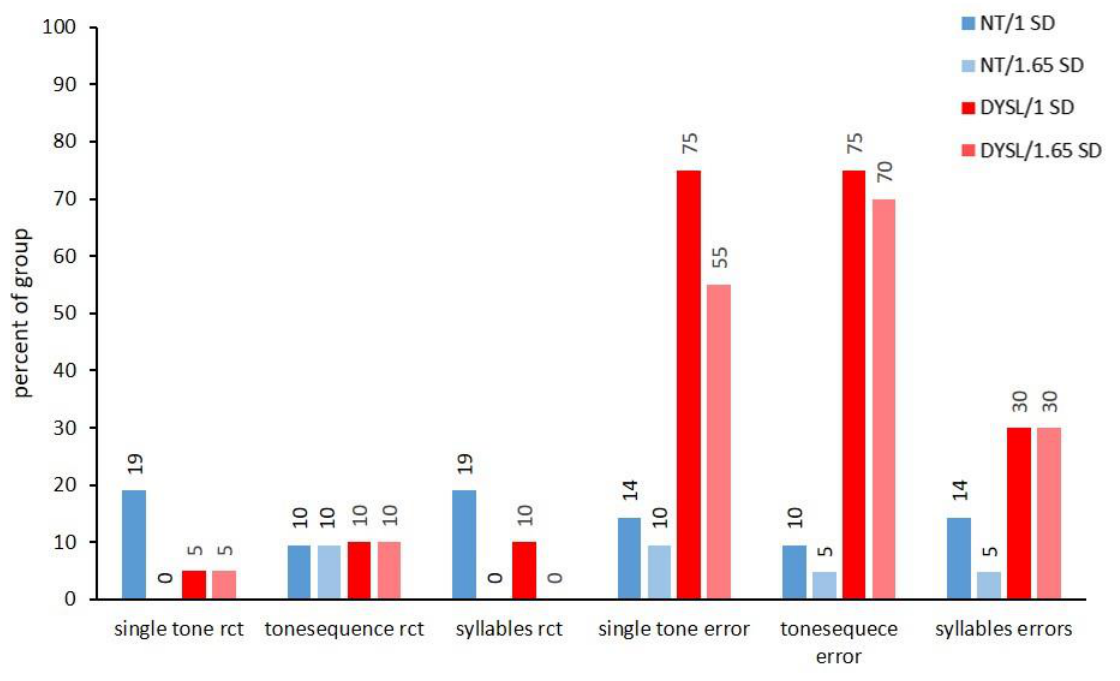
Figure 3. Deviating performance/auditory subtests. Auditory subtests. NT: neurotypical normal reading children, DYSL: children with dyslexia, rct: reaction time.